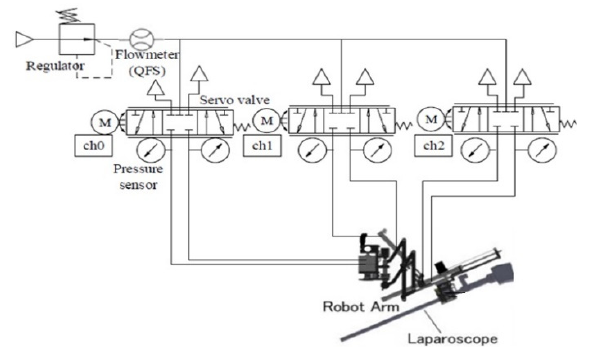
Figure 21. Pneumatic circuit.